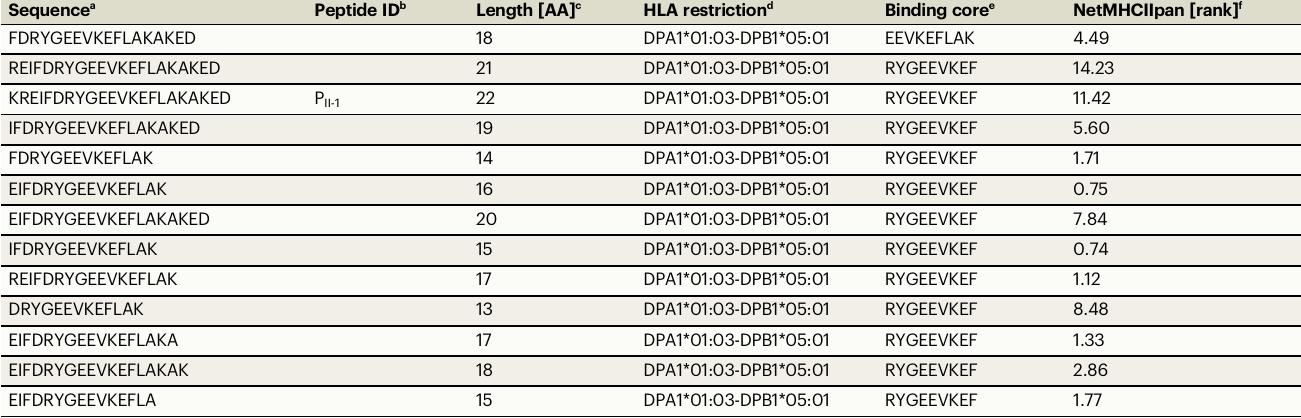
P II-1 -derived HLA classII-presented length variants of experimentally eluted P II-1 -loaded mature monocyte-derived dendritic cells(moDCs) identi fi edbymass spectrometry-based immunopepti- domics. AA aminoacid. a HLA class II peptide aminoacid sequence. b Abbreviated peptidename. c Peptideaminoacid length. d Best predicted HLA